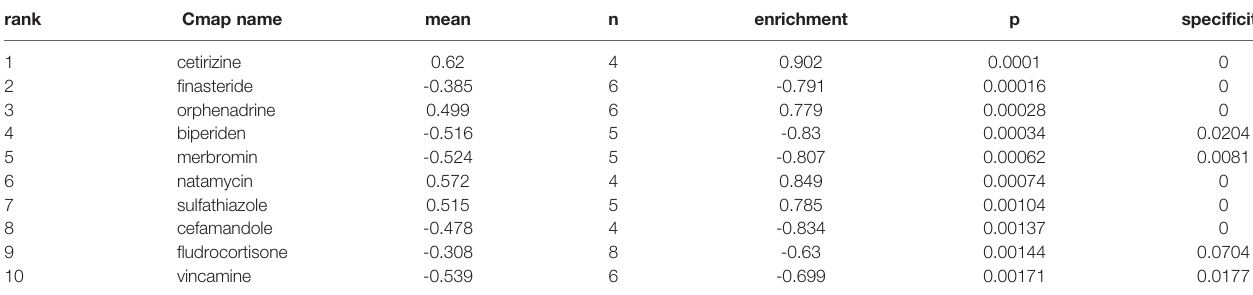
TABLE 3 | The results of CMAP analysis.